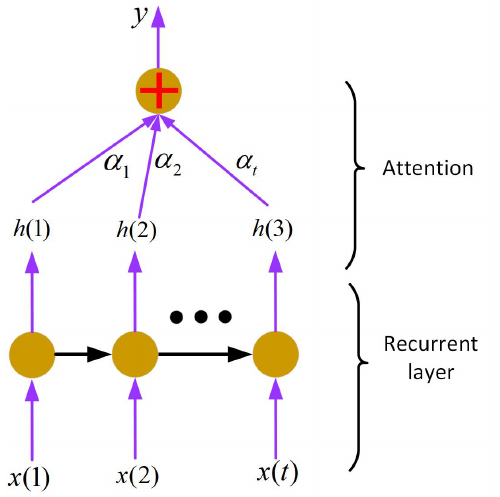
Figure 5. Recurrent layer with an attention